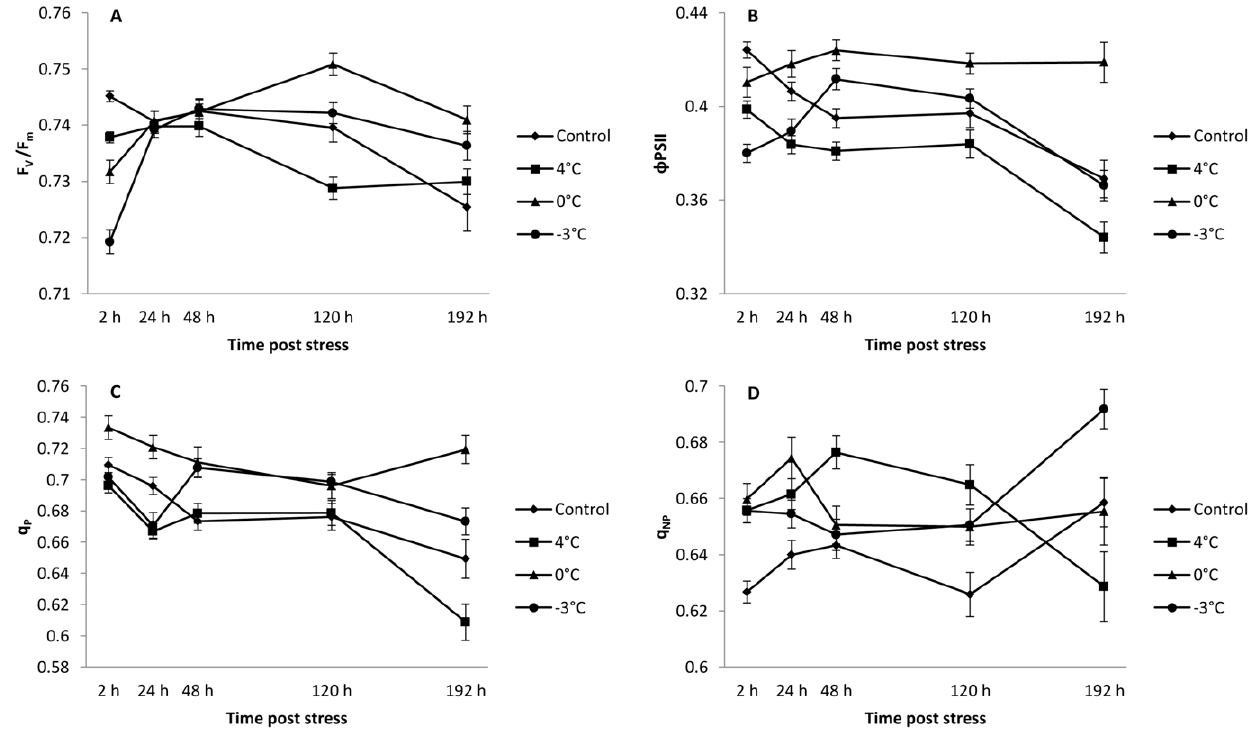
Figure 2. Changes in (A) maximum efficiency of PSII photochemistry after dark adaptation (F v /F m ), (B) effective PSII quantum yield ( W PSII), (C) photochemical quenching (q P ) and (D) non-photochemical quenching (q NP ) in control and 4 6 C, 0 6 C or 2 3 6 C-treated flowers. Measurements were performed 2, 24, 48, 120 and 192 h after cold treatment. Values are means 6 standard errors (n=45). doi:10.1371/journal.pone.0046976.g002 PLOS ONE |